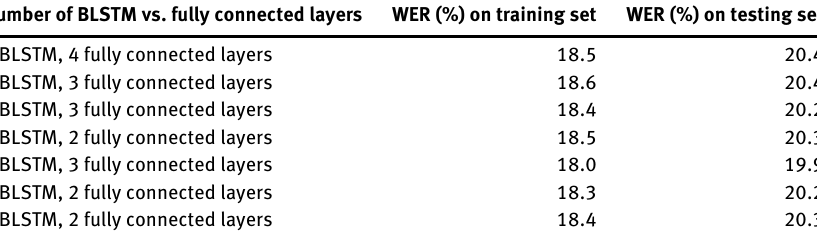
Table 5: WER as a Function of the Number of BLSTM Layers and Fully Connected Layers. Number of BLSTM vs. fully connected